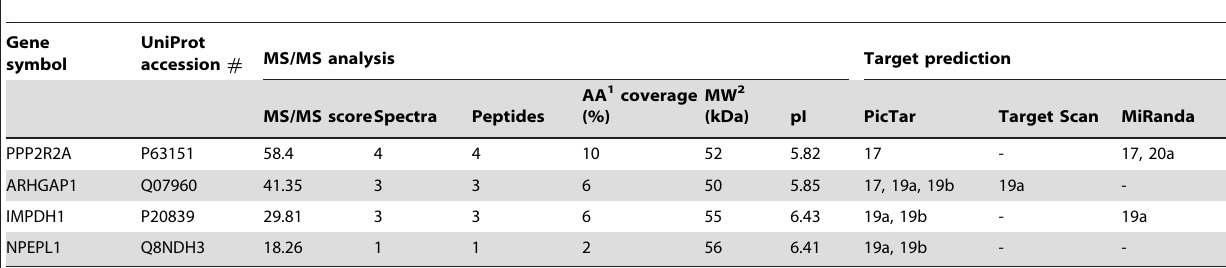
Table 1. Selection of candidate genes by computer-aided algorithms to search for miRNA target sites.